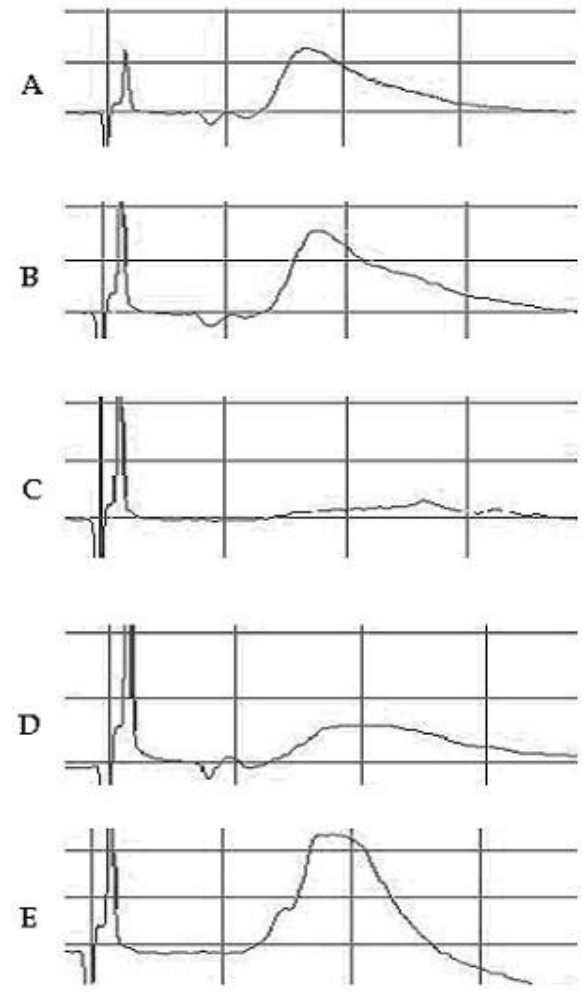
Figure 6. Averaged signals obtained by 200 evoked end-plate currents recorded at mouse neuromuscular junction. The figure shows digitized raw data related to control (A), treatment with NeuTX-I concentration of 5 μ g/ml (B) and 10 μ g/ml (C); the effects obtained after a wash out (D) and a subsequent flow of a physiological solution with calcium concentration increased from 1 to 1.5mM (E). Calibration bars, vertical: 2nA, horizontal: